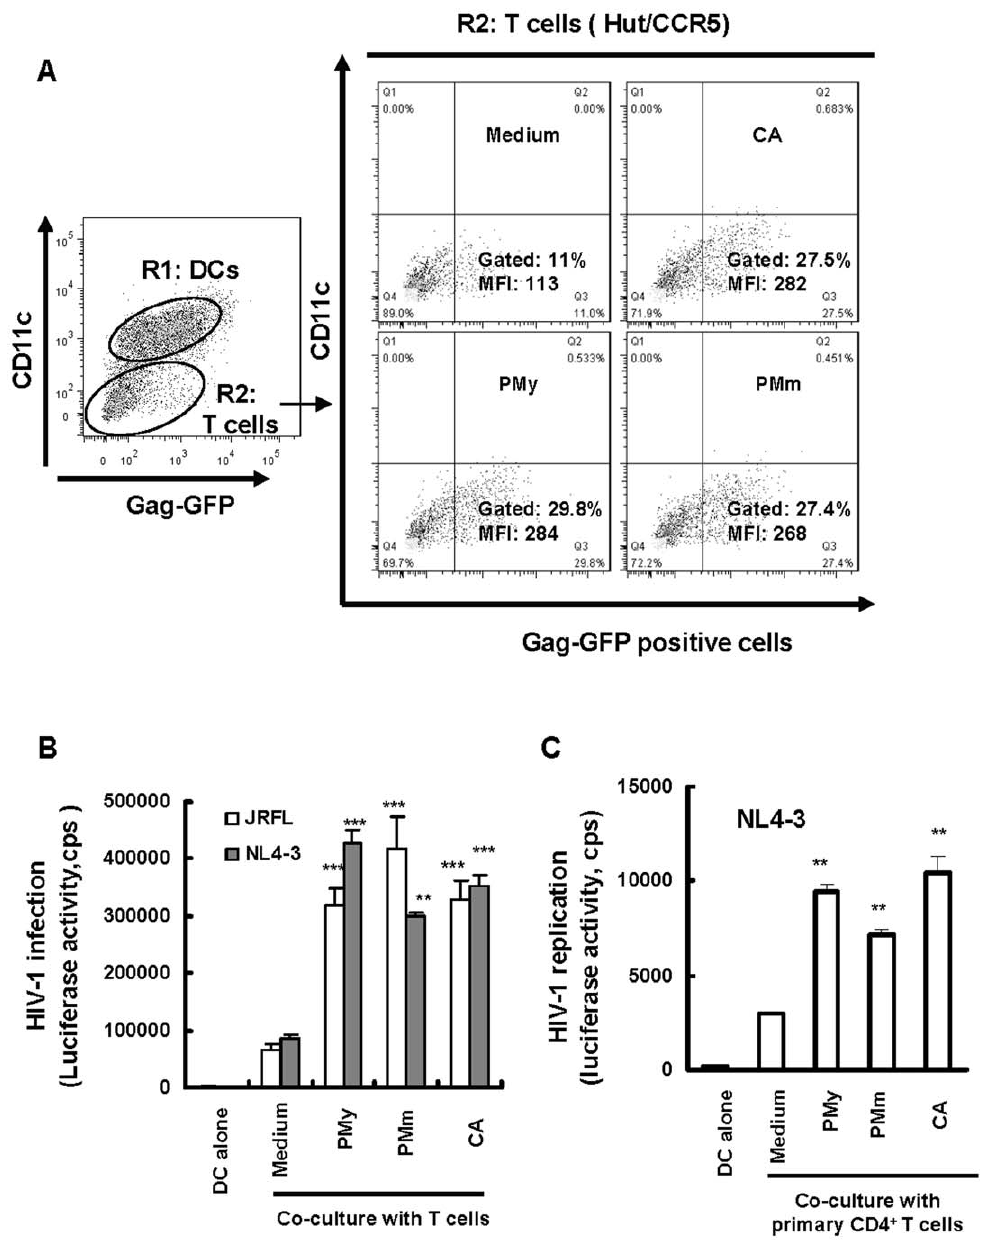
Figure 3. Fungal stimulation promotes MDDC-mediated HIV-1 transmission to CD4 + T cells. Immature MDDCs were treated with heat- killed fungi species as described in Figure 2. After pulsing with 40 ng p24 gag amounts of HIV-1 VLPs (A), or with 5 ng p24 gag amounts of pseudotyped HIV-Luc/NL4-3 or HIV-Luc/JRFL(B and C), CD4 + T target cells were added for co-culture, HIV-1 VLP transfer was detected either by flow cytometry after 30 min (A), or by measuring HIV-1 infection after 3 days co-culture (B and C). (A) Enhanced viral association with Hut/CCR5 cells mediated by fungus- stimulated MDDCs. Hut/CCR5 cells (CD11c - ) were gated from co-culture, and viral association was measured by detecting Gag-GFP level by flow cytometry. The positive percentages and the values of MFI from one representative out of three experiments are shown; (B, C) Increased HIV-1 trans infection mediated by fungus-stimulated MDDCs, either with Hut/CCR5 cells (B) or PHA-activated autologous primary CD4 + T cells as target cells (C). Asterisks indicate significantly enhanced HIV-1 trans infection mediated by fungus-treated MDDCs compared with that of medium-treated cells (** P , 0.01, *** P , 0.001, paired t test); Results of one representative experiment out of four are shown. All data are means 6 SD. cps, counts per second.